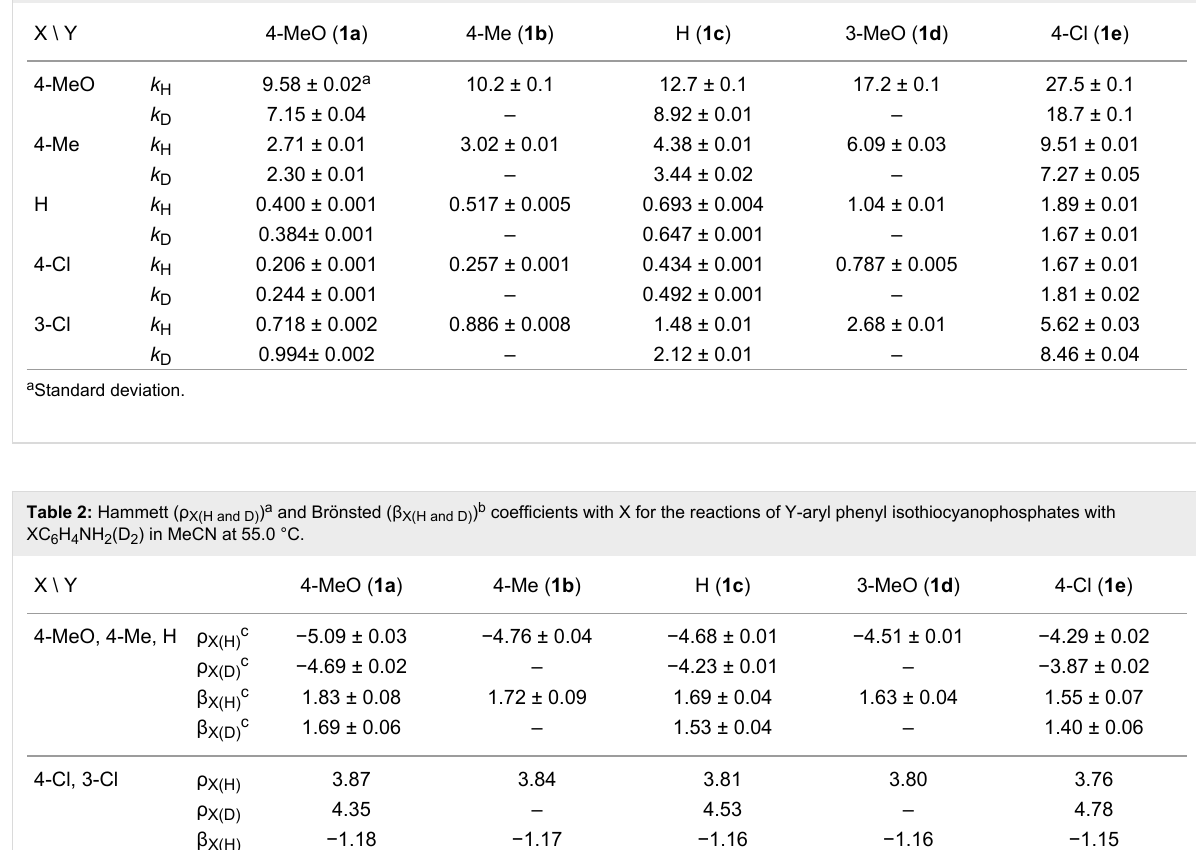
Table 1: Second-order rate constants ( k (H and D) × 10 3 /M –1 s –1 ) of the reactions of Y-aryl phenyl isothiocyanophosphates with XC 6 H 4 NH 2 (D 2 ) in MeCN at 55.0 °C. X \ Y